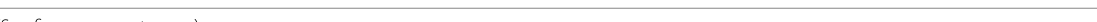
figure on next Fig. 7 ISM1 deficiency increased proinflammatory cytokine/chemokine production in lung and promoted LPS-induced NF-κB activation. a Lung cytokine/chemokine profile determined by an inflammatory cytokine antibody array using lung homogenates at 24 h post LPS challenge. * represents p < 0.05. n 4 mice per group, 1 total lung lysate per mouse. b , c Increased levels of TNF-α in Ism1 − / − lung 24 h post LPS challenge = shown by Western blot of whole lung lysate. ** represents p < 0.01. n 3 mice per group, 1 total lung lysate per mouse. d , e IF staining showing = increased p65 NF-κB nuclear translocation in Ism1 − / − lung. Representative images showing increased signal co-localization of the p65 NF-κB (red) and the DAPI nucleus (blue) in the lung sections of Ism1 − / − mice d and the quantification of nuclear p65 NF-κB in panel d, showing the percentage of cells with nuclear localized p65 in WT and Ism1 − / − lung ( e ). n 5 mice per group, 2 sections per lung, 5 microscopic fields per section. f rISM1 = dose-dependently suppresses LPS-induced NF-κB p65 phosphorylation at S276 and S536 in cultured mouse MH-S alveolar macrophage cells. Cells are harvested at 30 min post LPS treatment (100 ng/ml). Based on two independent